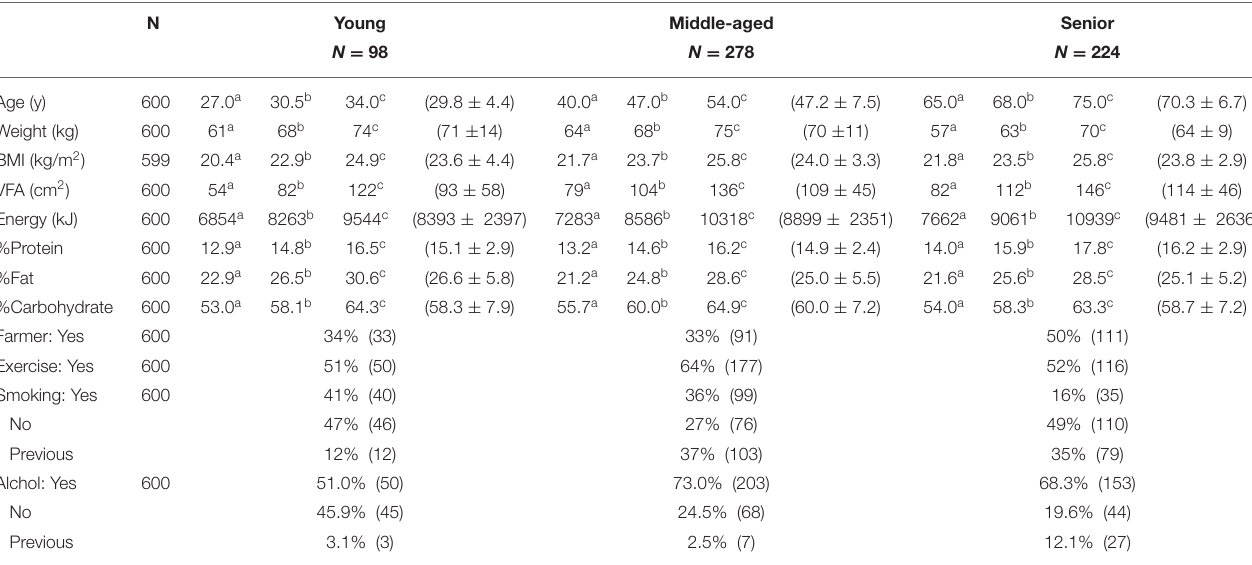
TABLE 2 | Background descriptive statistics by age-group in male